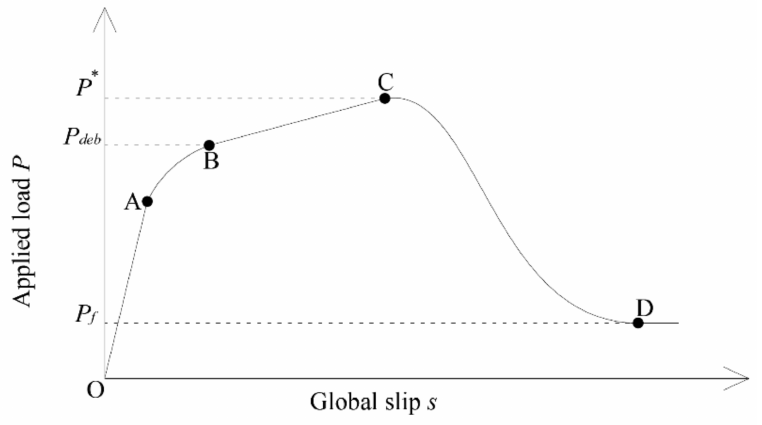
Figure 5. Idealized applied load P , global slip s .